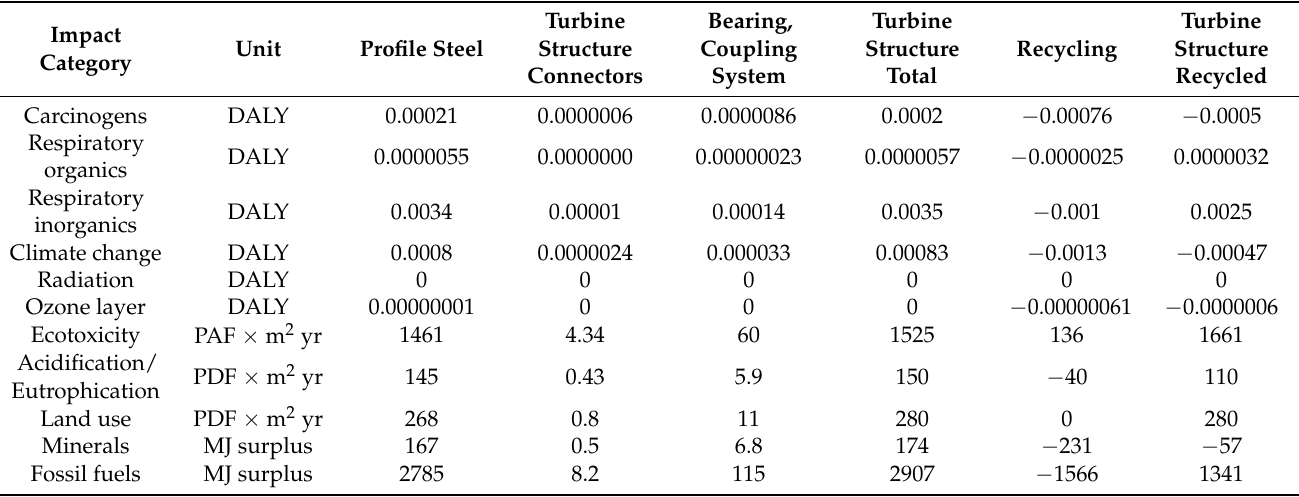
Table 5. Results of characterization of environmental impacts at the manufacturing and recycling stage of a turbine structure of an innovative wind turbine.